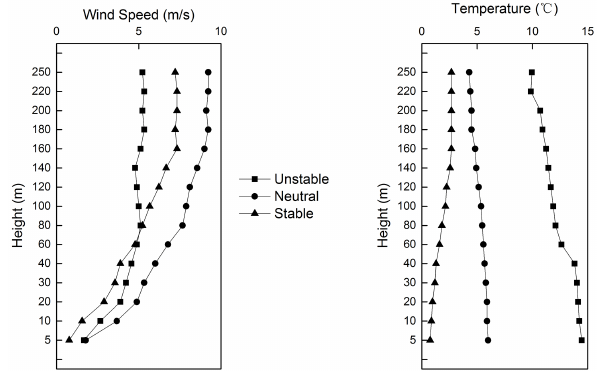
Figure 2. Vertical distribution profile of average wind speed and temperature in low atmosphere under different stability